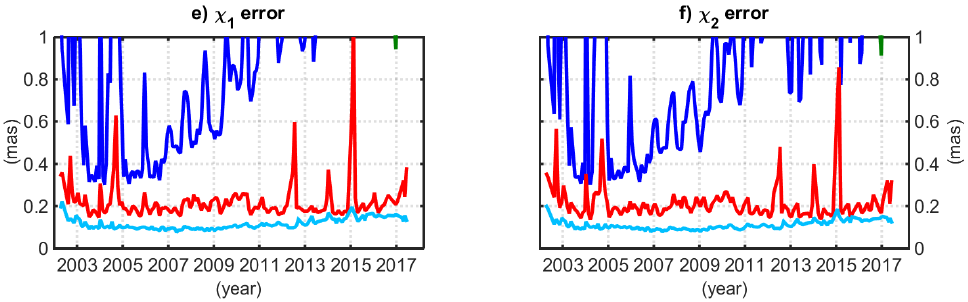
Figure 1. χ 1 ( a ) and χ 2 ( b ) components of GSMAM computed using ΔC 21 , ΔS 21 from different Gravity Recovery and Climate Experiment (GRACE) solutions and from GRACE + SLR and their standard errors ( c , d ). Plots of errors ( c , d ) were supplemented with the values of minimum, maximum, mean and standard deviation (STD) of errors. No filtering and no interpolation have been applied to the series. For better visibility, χ 1 ( a ) and χ 2 ( b ) time series have been shifted relative to each other by adding a bias; ( e ) and ( f ) show the same as ( c ) and ( d ) but with changed scale for y axis to show variability of GRACE + SLR errors.